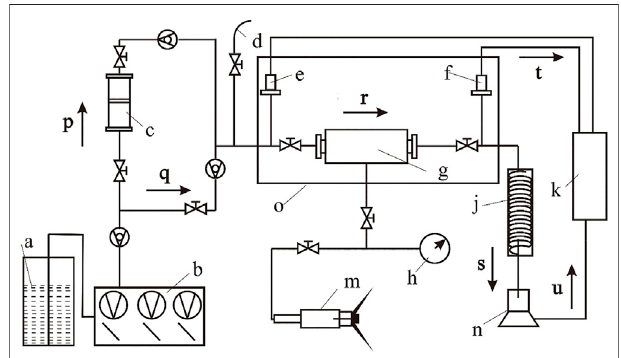
FIGURE 2 | Structure diagram of the core fl ow instrument. a, Ultrapure water; b, constant speed and pressure pump; c, intermediate container; d, safety valve; e, inlet pressure; f, outlet pressure; g, core holder; h, con fi ning pressure gage; j, condenser; k, data acquisition device; m, hand pump; n, electronic balance; o, blast oven; p, ultrapure water; q, chemical stimulant; r, injected fl uid; s, residual liquid; t, pressure data; u, velocity